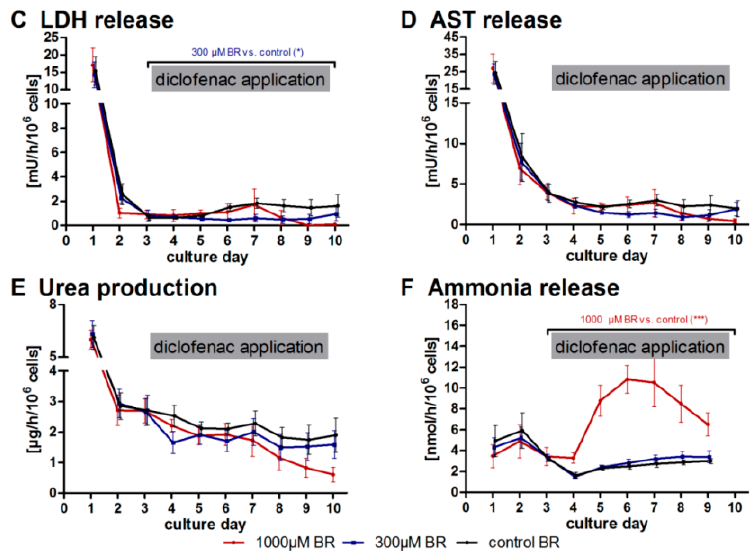
Figure 4. Time-course of clinical parameters in bioreactors with primary human liver cells treated or non-treated with diclofenac. Release respectively production rates in 300 µM bioreactors (300 µM BR) ( blue ) or 1000 µM bioreactors (1000 µM BR) ( red ) or in the non-treated control bioreactors (control BR) ( black ) were determined before (from Day 0 until 3) and during diclofenac application (from Day 3 until 10): production rates of glucose ( A ) and lactate ( B ) were measured as indicators for the overall metabolic performance; lactate dehydrogenase (LDH, C ) and aspartate transaminase (AST, D ) were determined as indicators of potential cell damage; and urea production ( E ) and ammonia release ( F ) as parameters for nitrogen metabolism. Values were normalized to 10 6 inoculated cells. The influence of the drug dose (Day 3–10) on the metabolic activity of the cells in comparison to the control was analyzed by means of one-way analysis of variance (ANOVA) with Dunnett’s multiple comparison test and significant changes (* = p < 0.05, *** = p < 0.001) are indicated in the graphs ( n = 3, mean ± SEM).